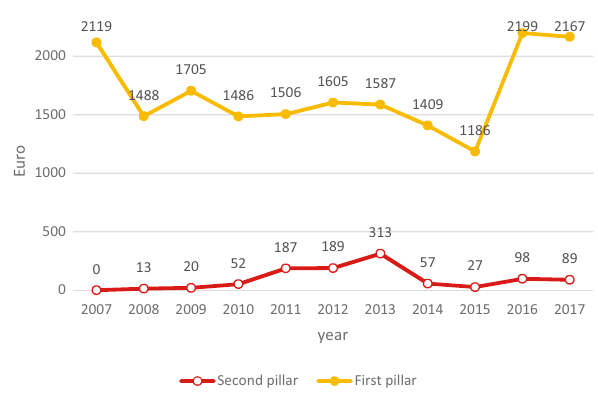
Figure 4: Average value of fi nancial subsidies allocated under the fi rst and second pillars of the Common Agricultural Policy to Romanian farms ( source: author ’ s own elaboration on data https:// ec.europa.eu/agriculture/rica/database/database_en.cfm ) .